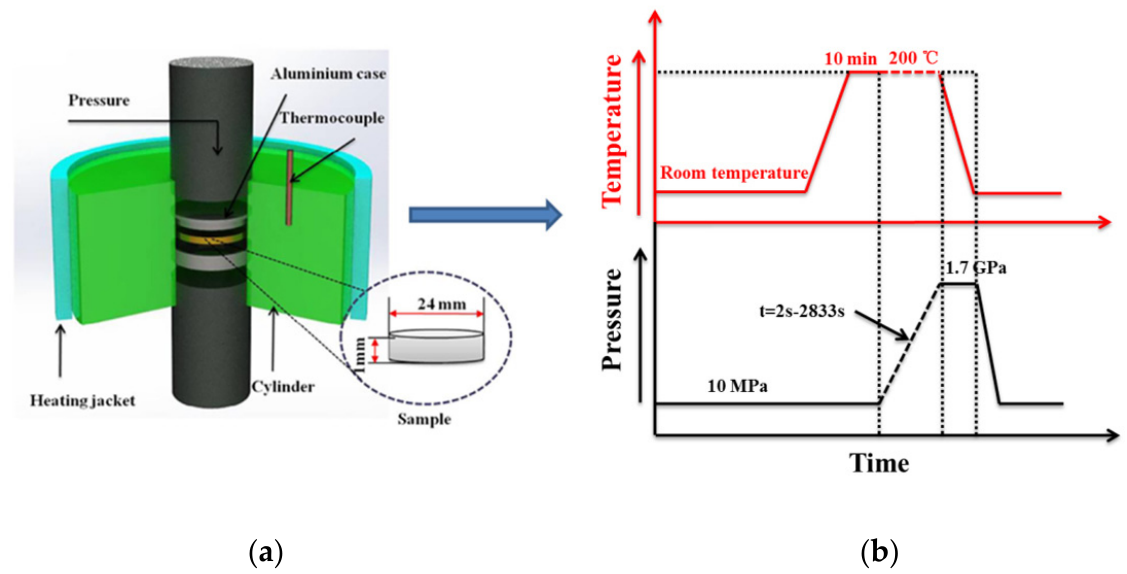
Figure 1. ( a ) Schematic of the high-pressure cell; ( b ) the temperature and pressure protocol.